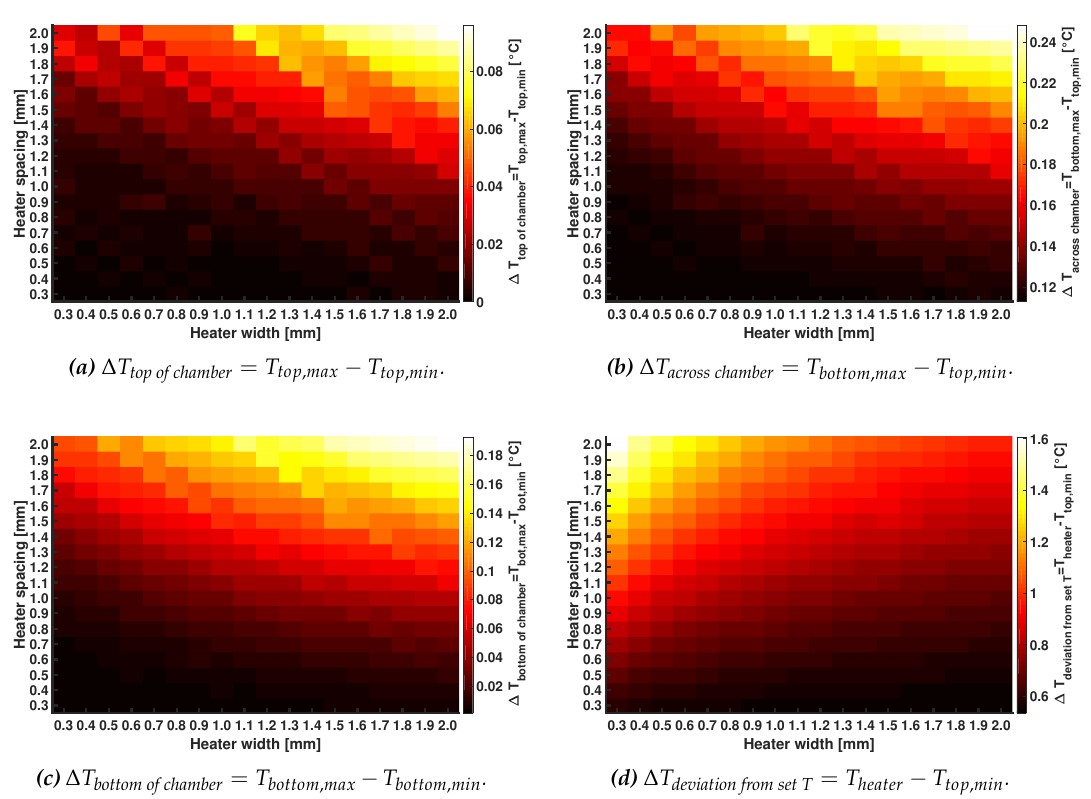
Figure 6. Three temperature differences within the system. In panel ( a ) the ∆ T top of chamber , in panel ( b ) the ∆ T across chamber , in panel ( c ) the ∆ T bottom of chamber , and in panel ( d ) the ∆ T deviation from set T are shown for different heater widths (0.3mm to 2.0mm, in the columns) and heater spacings (0.3mm to 2.0mm, in the rows). The differences are obtained using a parametric sweeps for both the heater width and heater spacing in the COMSOL Multiphysics 5.3a finite element method heat transfer simulations. The cells in dark indicate the smallest ∆ T and the cells in white the largest ∆ T